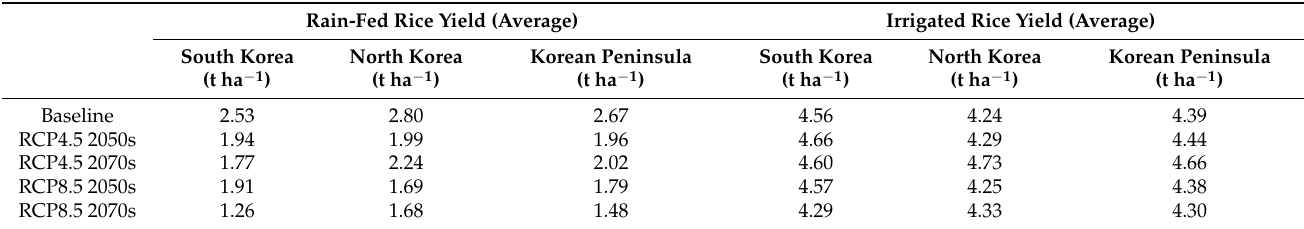
Table 2. Rain-fed and irrigated rice yields under baseline and future climate